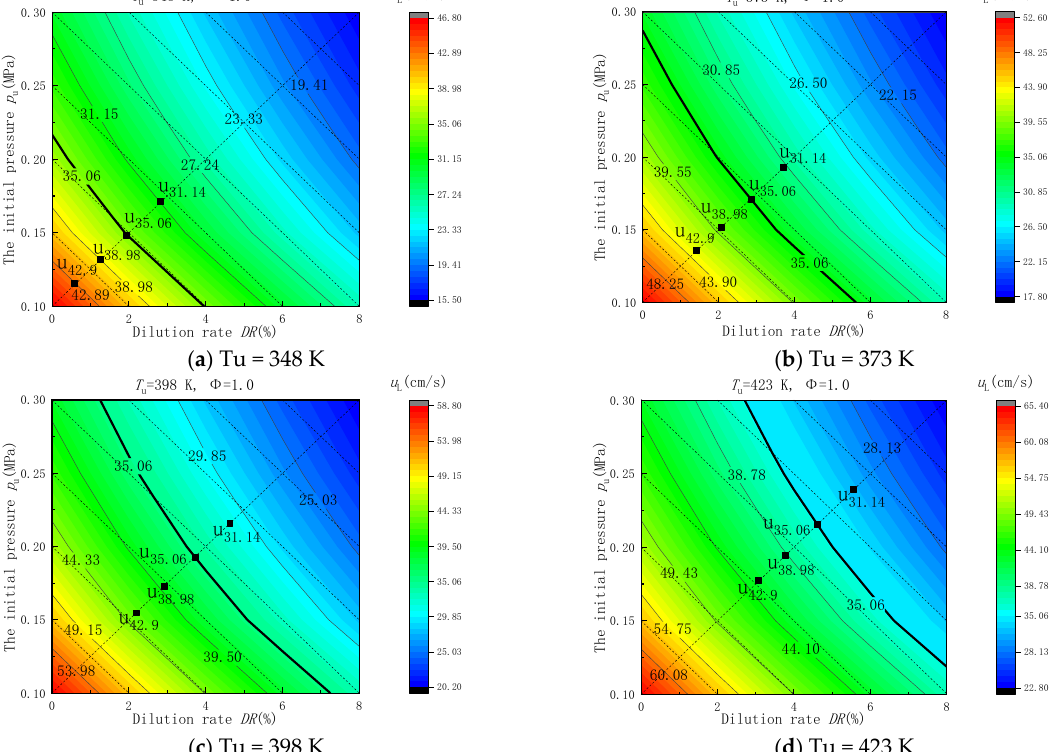
Figure 13. Equivalent distribution pattern of u L under the coupling effect of Pu and DR when Φ is 1.0 and when the initial temperatures are 348 K, 373 K, 398 K and 423 K.